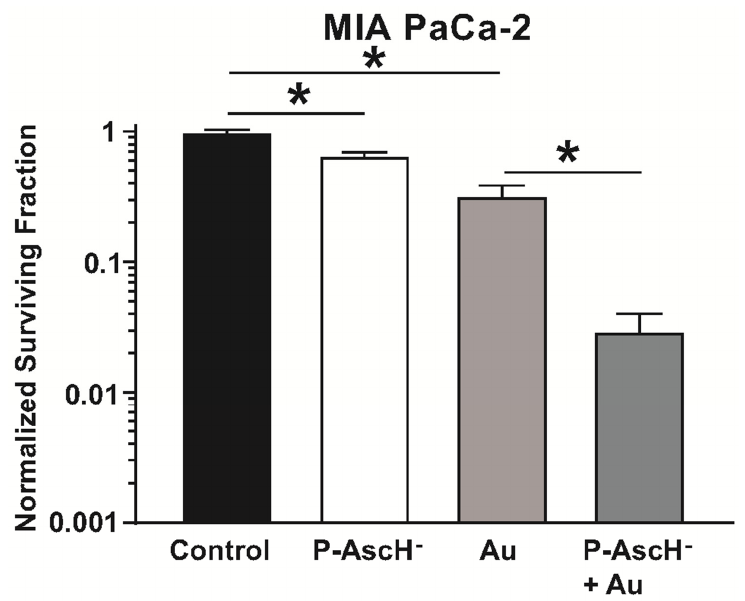
Figure 4. Au sensitizes pancreatic cancer cells to P-AscH − . Clonogenic cell survival of MIA PaCa-2 cells incubated with Au (1 µM for 3 h) followed by 2 mM P-AscH − (1 h) was significantly decreased compared to control and to either treatment alone. Treatment with either Au or P-AscH − also decreased clonogenic survival compared to control. Data represent normalized surviving fractions compared to control ± SE (* p < 0.01; one-way ANOVA with Tukey’s multiple comparisons). Reprinted/adapted with permission from [102,103]. Copyright 2017 Elsevier. Cancer cell killing by P-AscH − has been shown to be dependent on extracellular H 2 O 2 [33,41]. Thus, the overexpression of catalase or addition of bovine catalase in media was hypothesized to partially or completely rescue cancer cells from toxicity, mediated by the combination of P-AscH − and Au. P-AscH − was again dosed at the ED 50 of the cell line, as determined in previous experimentation [43]. P-AscH − caused slightly more cell death in this set of experiments (~40% vs. ~60% in Figure 4), though this small difference is not uncommon [43]. The addition of bovine catalase to cell media prevented the synergistic effect of Au/P-AscH − in pancreatic cancer cells (Figure 5) [102]. These findings support the hypothesis that H 2 O 2 is responsible for the effects of P-AscH − when cells are treated with Au and P-AscH − in combination.